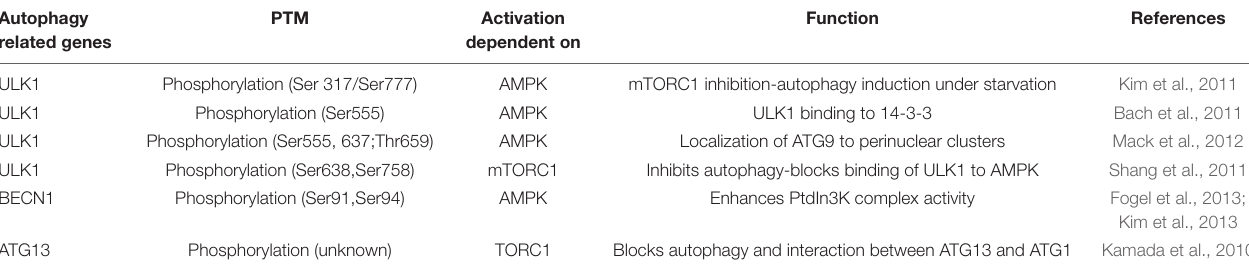
TABLE 1 | Phosphorylation sites of autophagy related genes induced by the AMPK/mTOR signaling pathway. Autophagy PTM Activation related genes dependent on